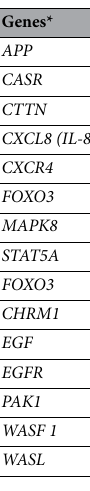
Table 4. Unique genes from case dominated preterm birth clusters shown in Fig. 2: Cluster A and Cluser